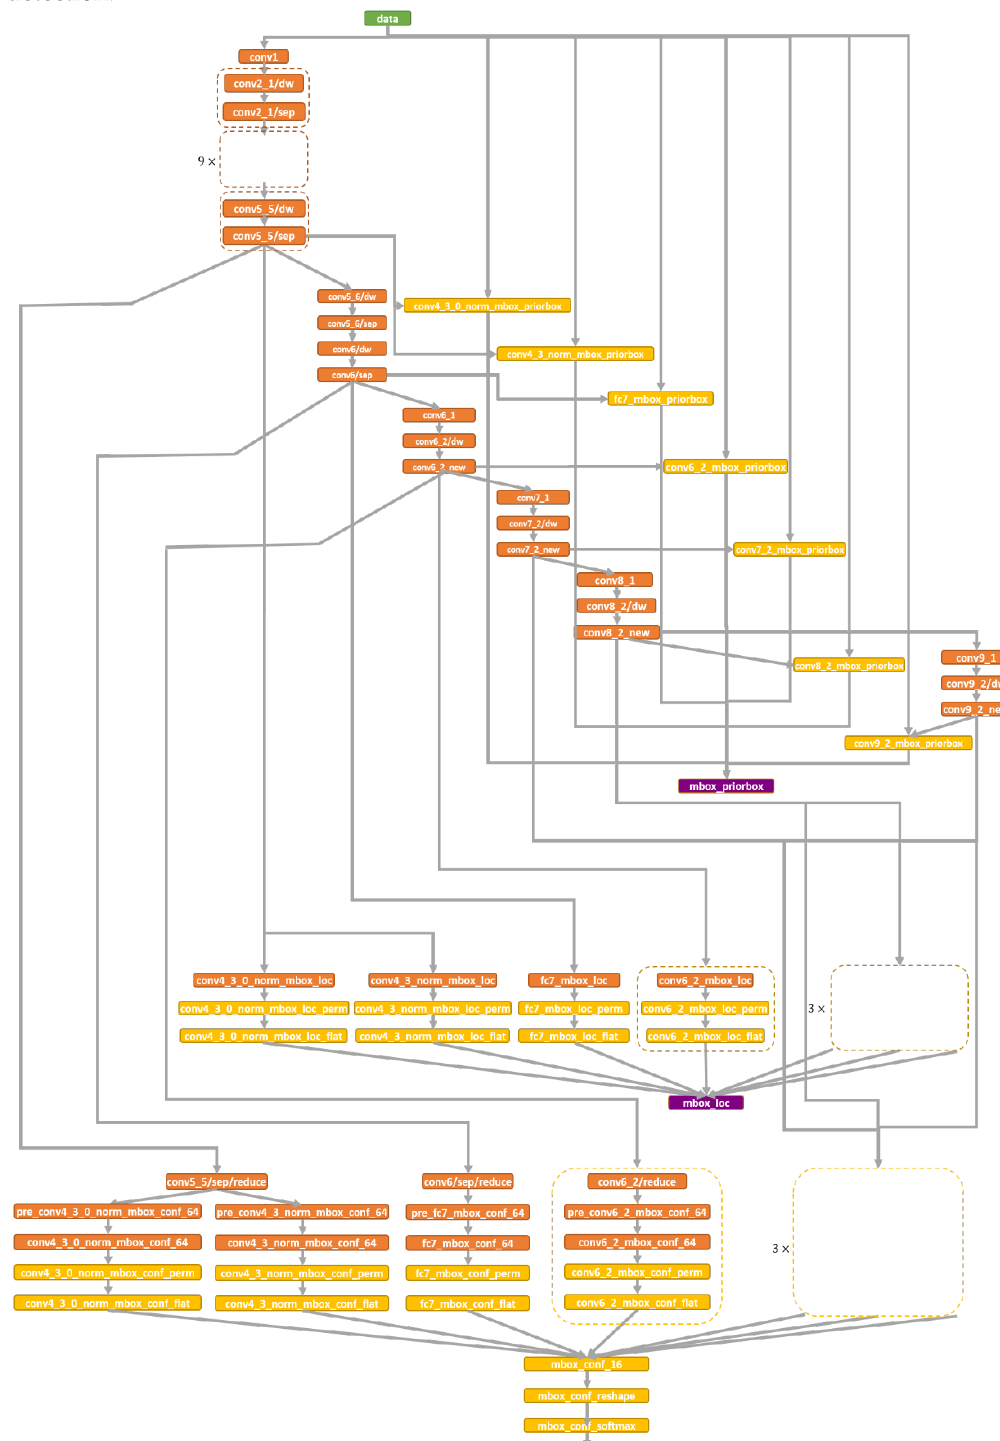
Figure 3. Architecture of the face detection network.